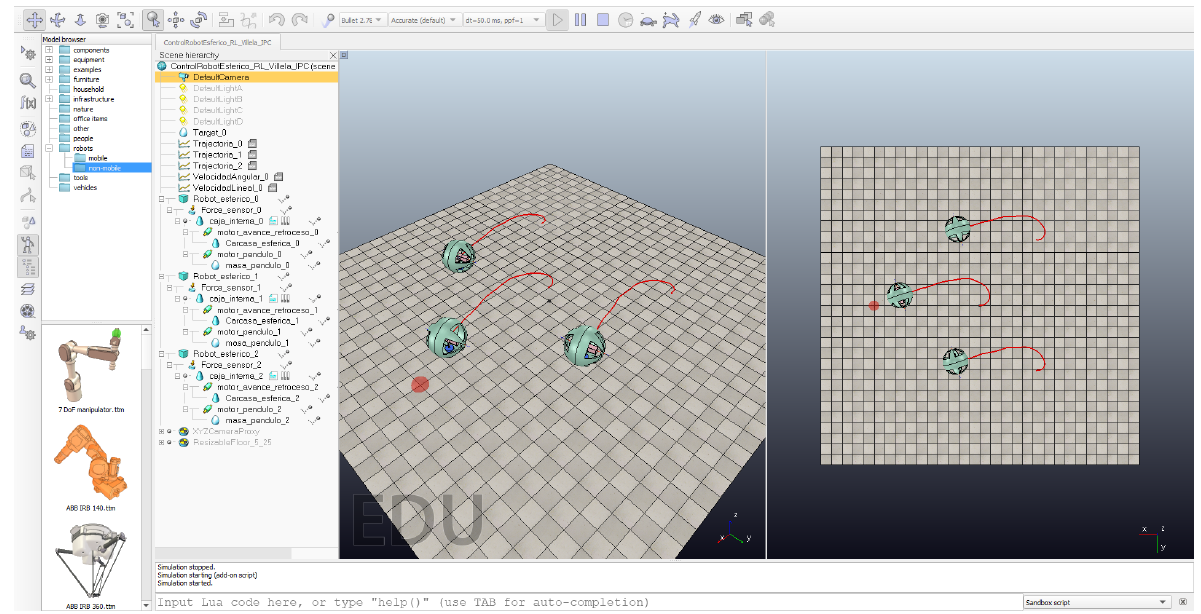
Figure 15. Formation control